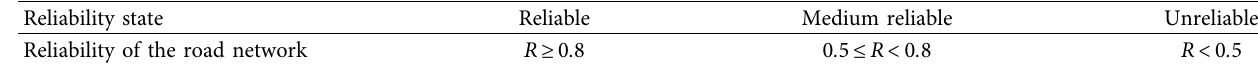
Table 8: The reliability state of the road network.